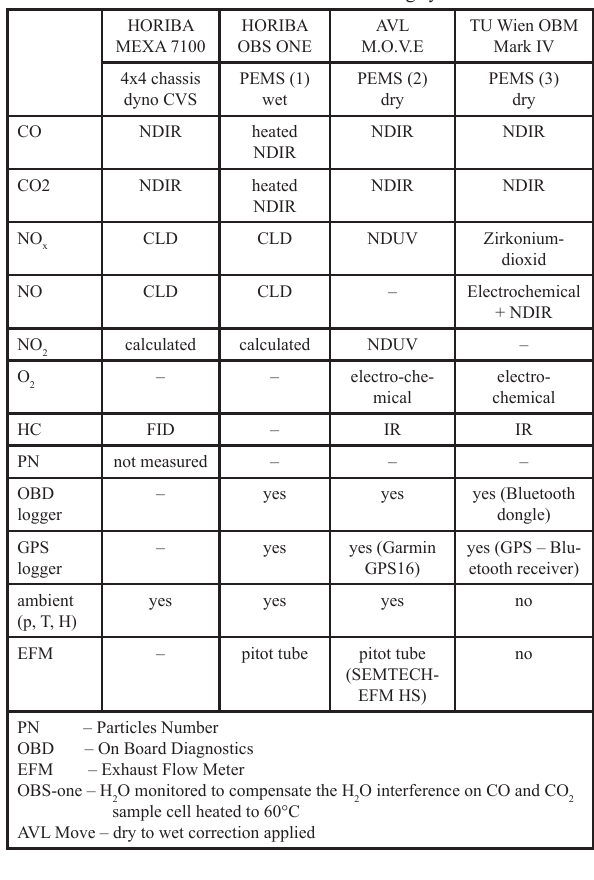
Table 3. Overview of used measuring systems